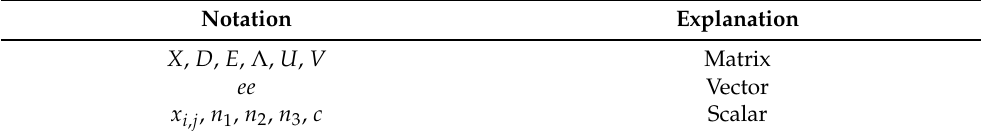
Table 2. The notation of